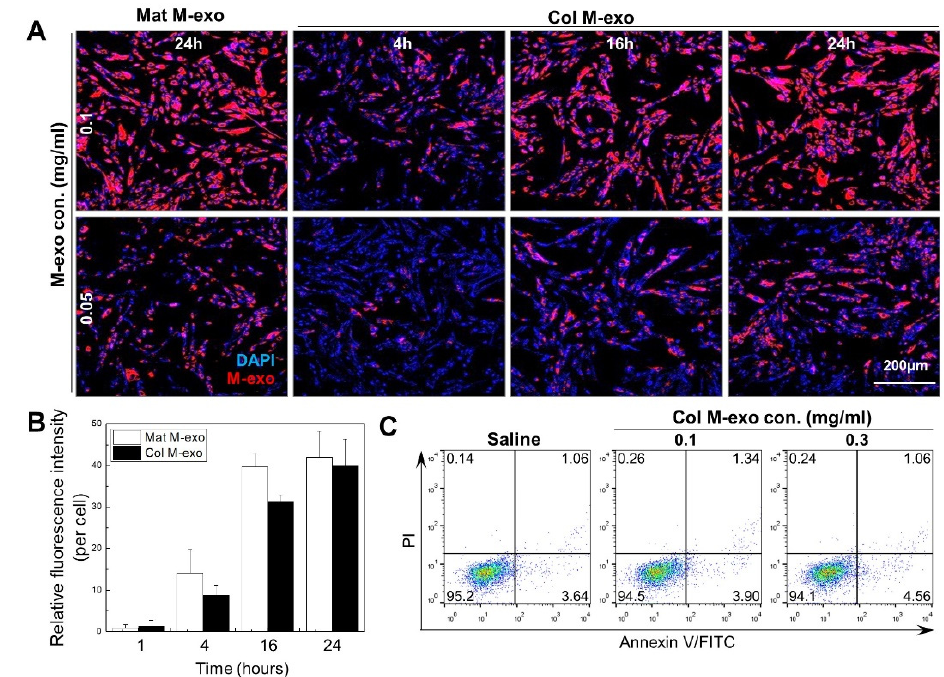
Figure 2. Cellular absorption tendency and cytotoxicity of milk exosomes. ( A ) Confocal microscopy image of HDFs after 4, 16, or 24 h incubation with 0.05 or 0.1 mg/mL of Cy5.5-labeled milk exosomes. Images of Cy5.5-labeled milk exosome (red) and DAPI (blue) were merged utilizing Leica Application Suite X software. Scale bar: 200 µ m. ( B ) Relative fluorescence intensity per Cy5.5-labeled milk exosome-internalized HDFs. ( C ) FACS histogram displaying cytotoxicity of HDFs treated with 0.1 and 0.3 mg/mL of Col M-exo.